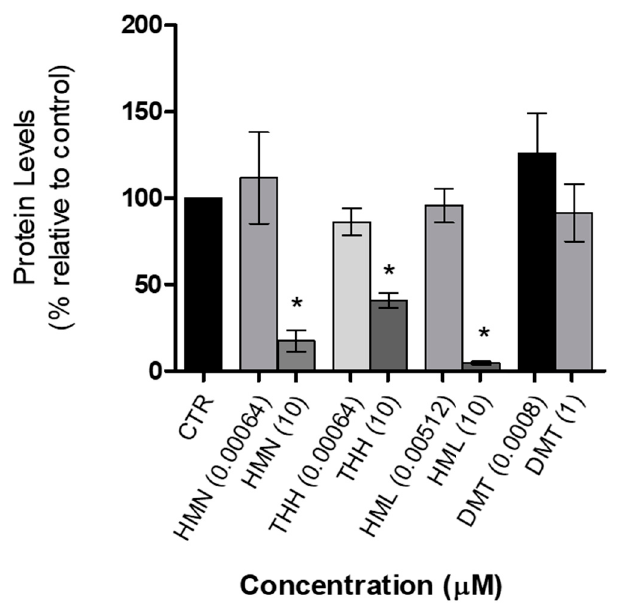
Figure 8. Protein levels when N27 cells are exposed during 24 h to HMN, THH, HML and DMT; CTR (control with untreated cells; 0.59 ± 0.08), HMN 0.00064 µM (0.65 ± 0.04), HMN 10 µM (0.19 ± 0.02), THH 0.00064 µM (0.56 ± 0.09), THH 10 µM (0.32 ± 0.05), HML 0.00512 µM (0.59 ± 0.04) and HML 10 µM (0.14 ± 0.0006); DMT 0.0008 µM (0.73 ± 0.02); DMT 1 µM (0.59 ± 0.03). n = 3, values are shown as mean ± SEM * indicates values that are significantly different from control p < 0.05, one-way analysis of variance followed by Dunnett’s multiple comparison test. CTR—control.